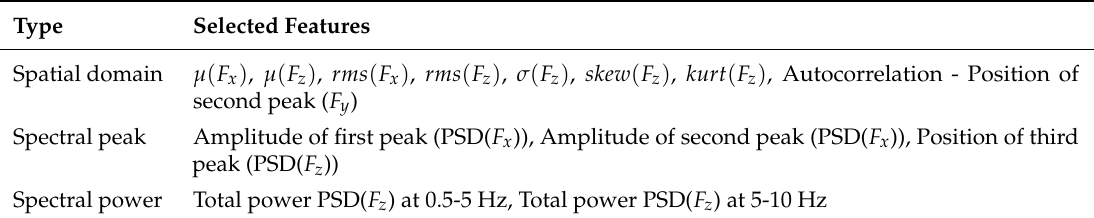
Table 4. List of selected